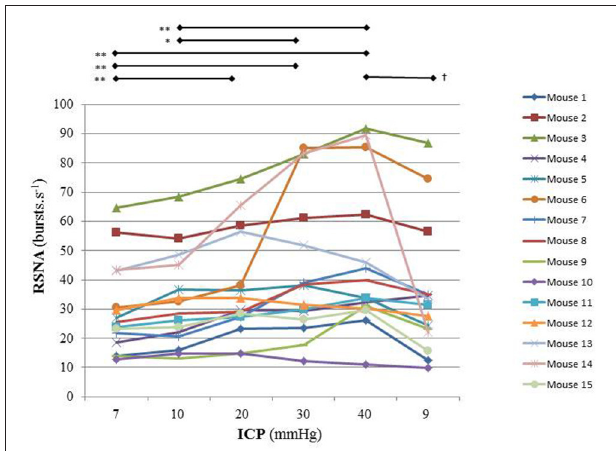
FIGURE 3 | Individual sympathetic activity in each mouse during modest ICP increase and decrease ( n = 15). Statistical analysis was performed using ANOVA for repeated measures with Tukey’s post-test. * p < 0.05, ** p < 0.01 vs. baseline and † p < 0.05 vs. plateau.